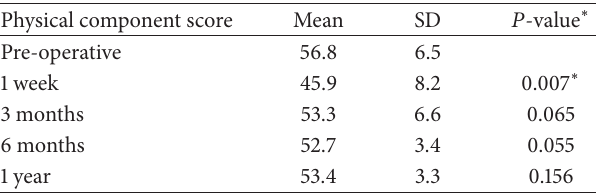
Table 2: Significance of changes in mean PCS scores of the SF-36 over the study